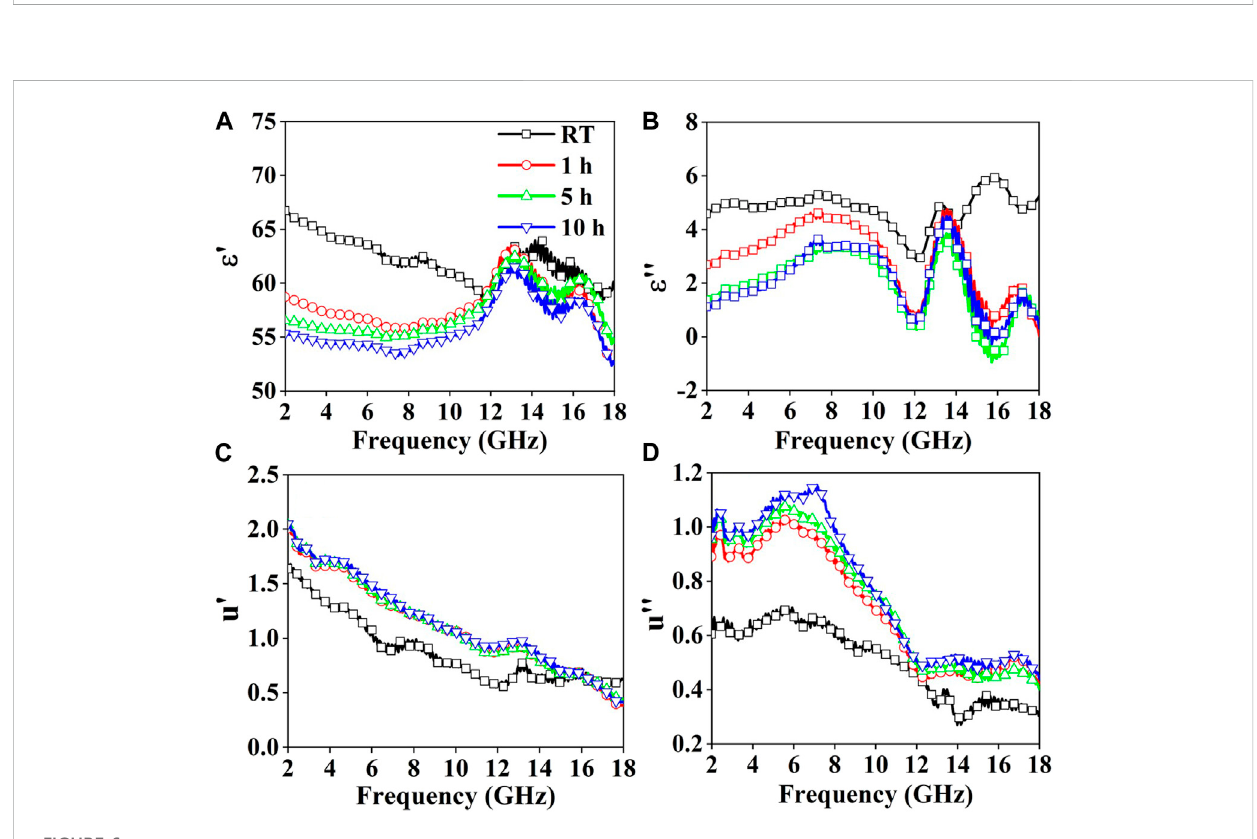
FIGURE 6 Electromagnetic properties of FeCoCr/silicone resin coatings after heat treatment at 400 ° C for different time: (A) real part of permittivity, (B) imaginary part of permittivity, (C) real part of permeability, (D) imaginary part of permeability.